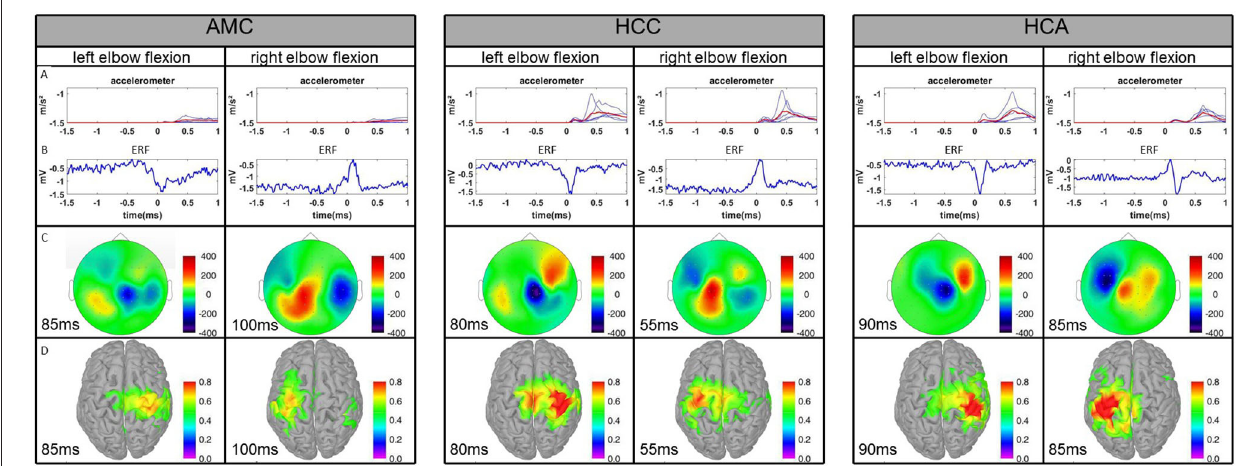
FIGURE 3 | Comparison of the averages of the three experimental groups. AMC, AMC patients; HCC, healthy control children; HCA, healthy control adults. (A) Plot of averaged accelerometer power for each subject for the left and right elbows. The red line represents the group average. (B) Averaged ERFs at the representative channel. (C) Topographies of averaged ERFs at maximum peak latency. Positive values indicate magnetic flux exiting the head (red colors) and negative flux entering the head (blue colors). (D) Source reconstruction of ERFs. Neural activity is superimposed on the individual cortex